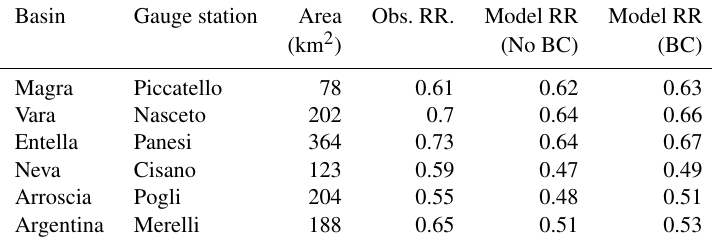
Table 6. Runoff ratios (RR) obtained by the modeling chain (with and without the rainfall bias correction) compared to those estimated by observations. Results are reported for the two cases: with (BC) and without (No BC) rainfall bias correction.